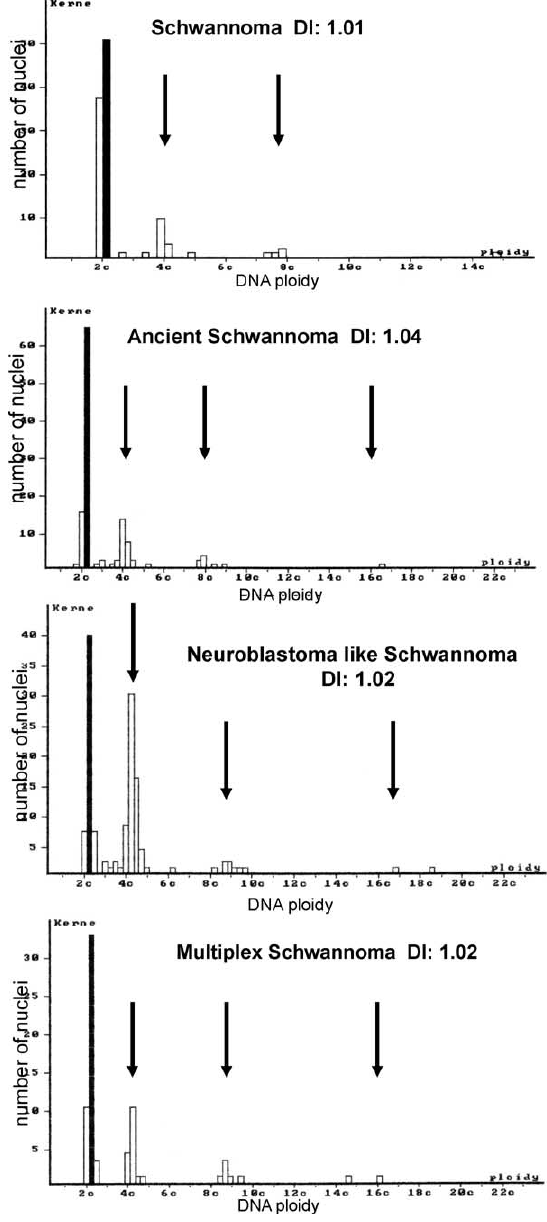
Fig. 2. Histograms of conventional, ancient, neuroblastoma like and multiplex schwannomas. Note the euploid polyploidisation indicated by arrows (4c, 8c, 16c values) and the 4c peak height values which are higher than 10%. Case numbers: 16, 18, 25, 27. rate of inappropriate cells was 4.1%, range: